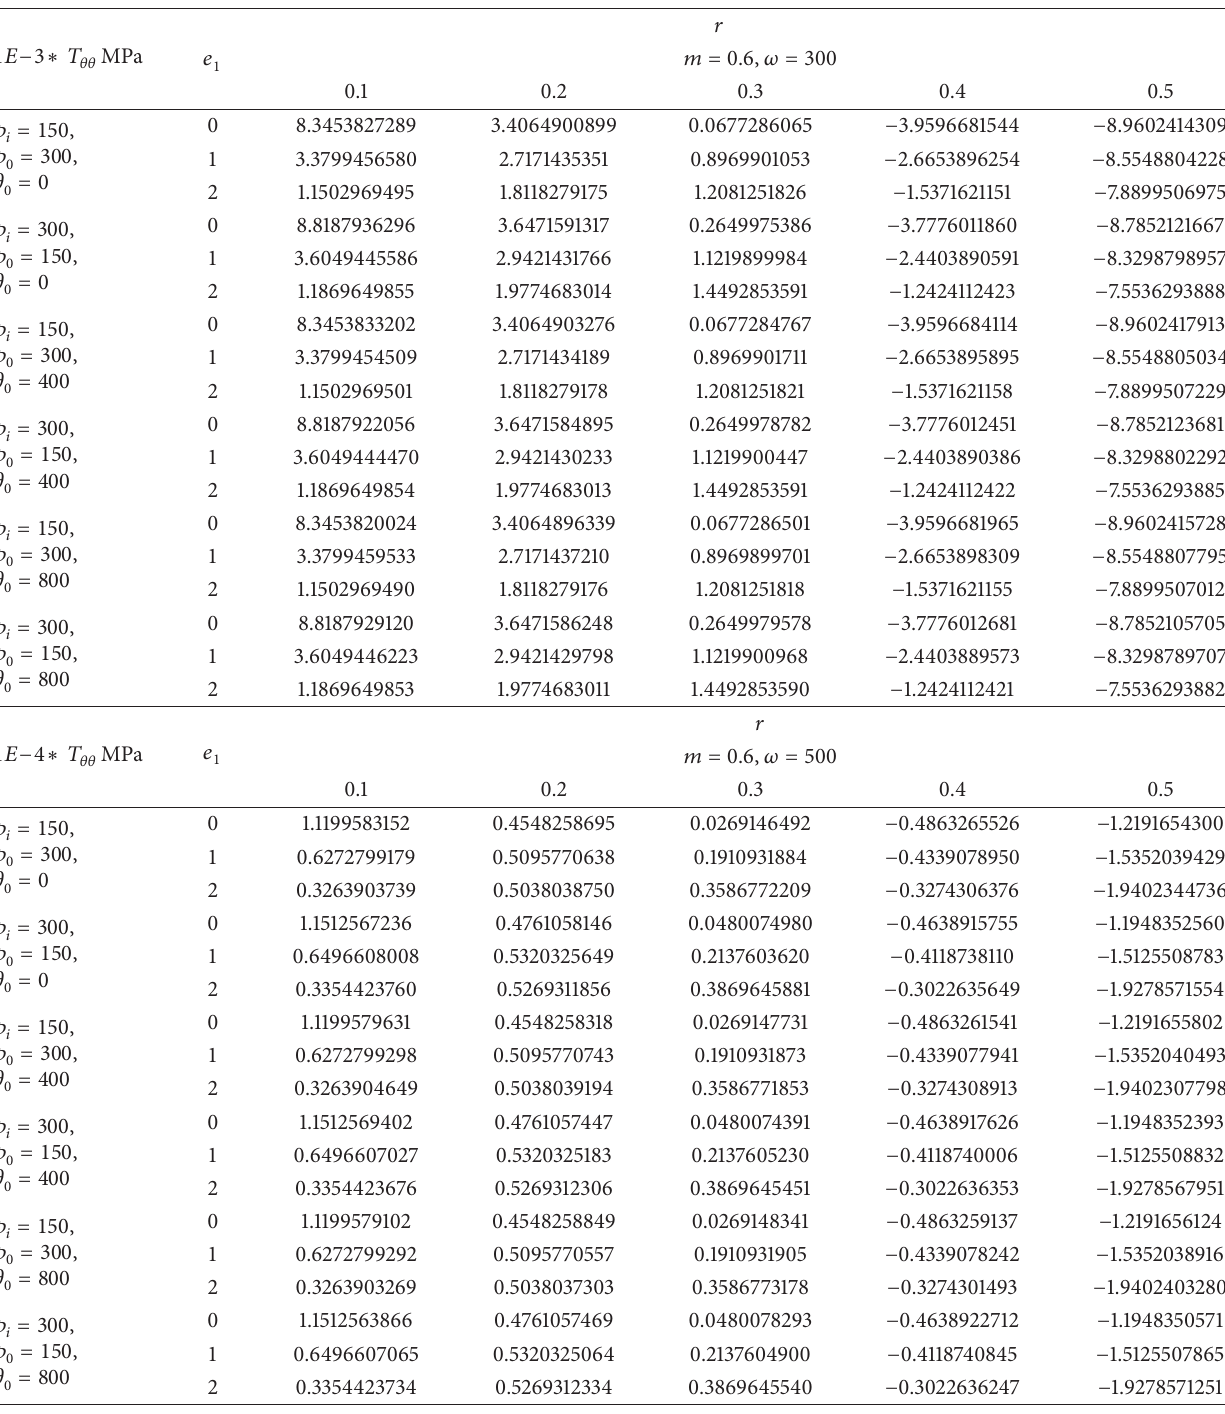
Table 2: Circumferential stresses for rotating cylinder with constant thickness and constant density with 𝜔 = 300, 500 , nonlinear strain hardening measure 𝑚 = 0.6 , and different parameters of Young’s modulus under internal and external